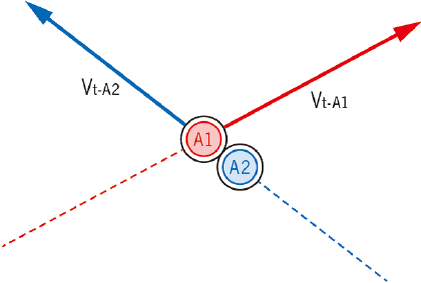
Fig. 13. AAs' original guidance to drive robots to the target positions: collision of robots.